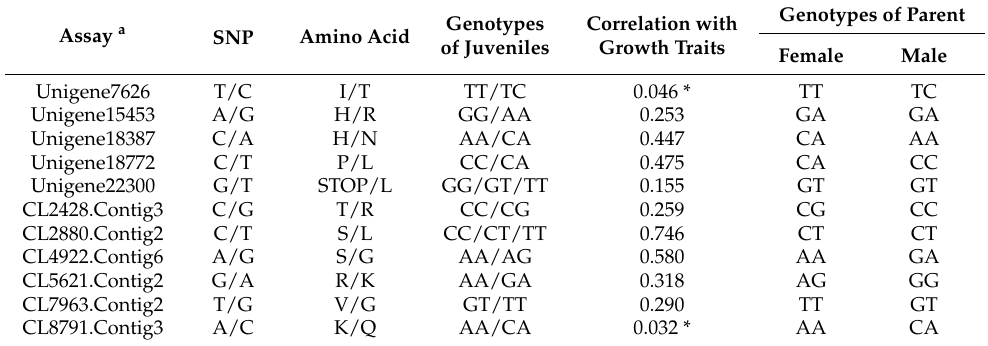
Table 2. Genotypes of 11 SNPs and their correlation with growth traits. Genotypes of Parent Genotypes of Assay a with Growth Traits